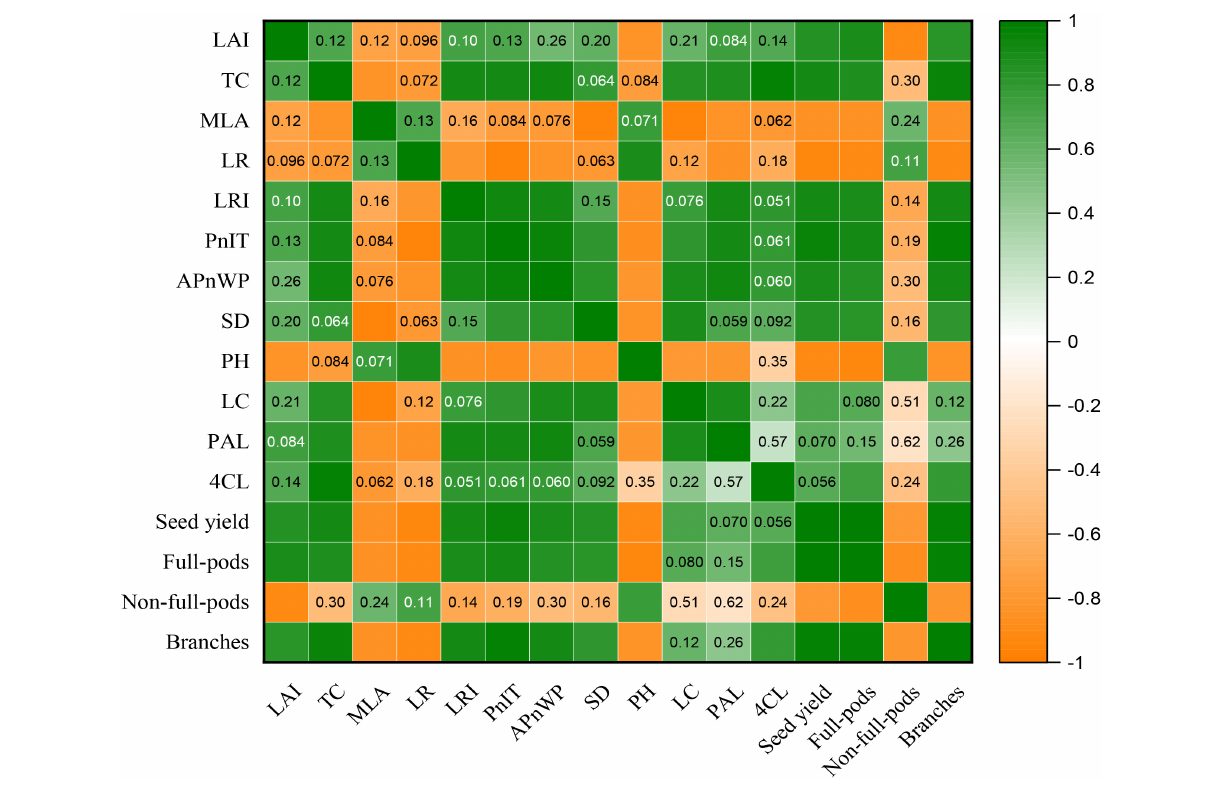
levels (Blad and Baker, 1972; Sakowska et al., 2018).